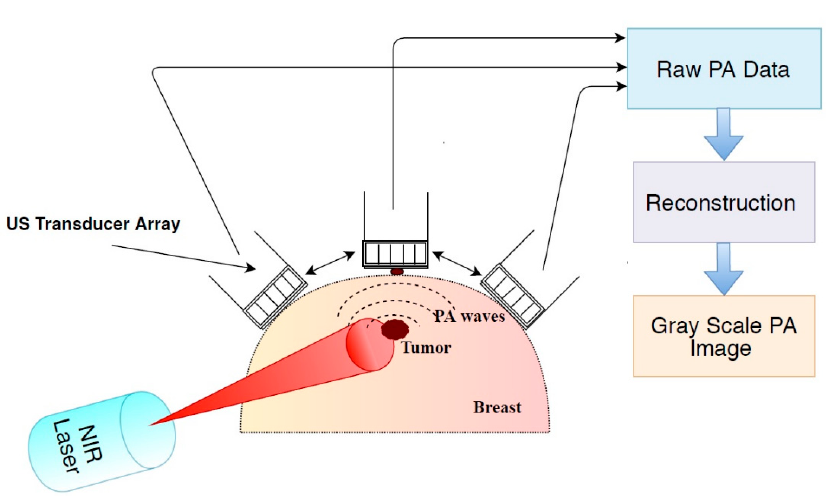
Figure 1. Schematic of the PAT system for breast cancer detection.